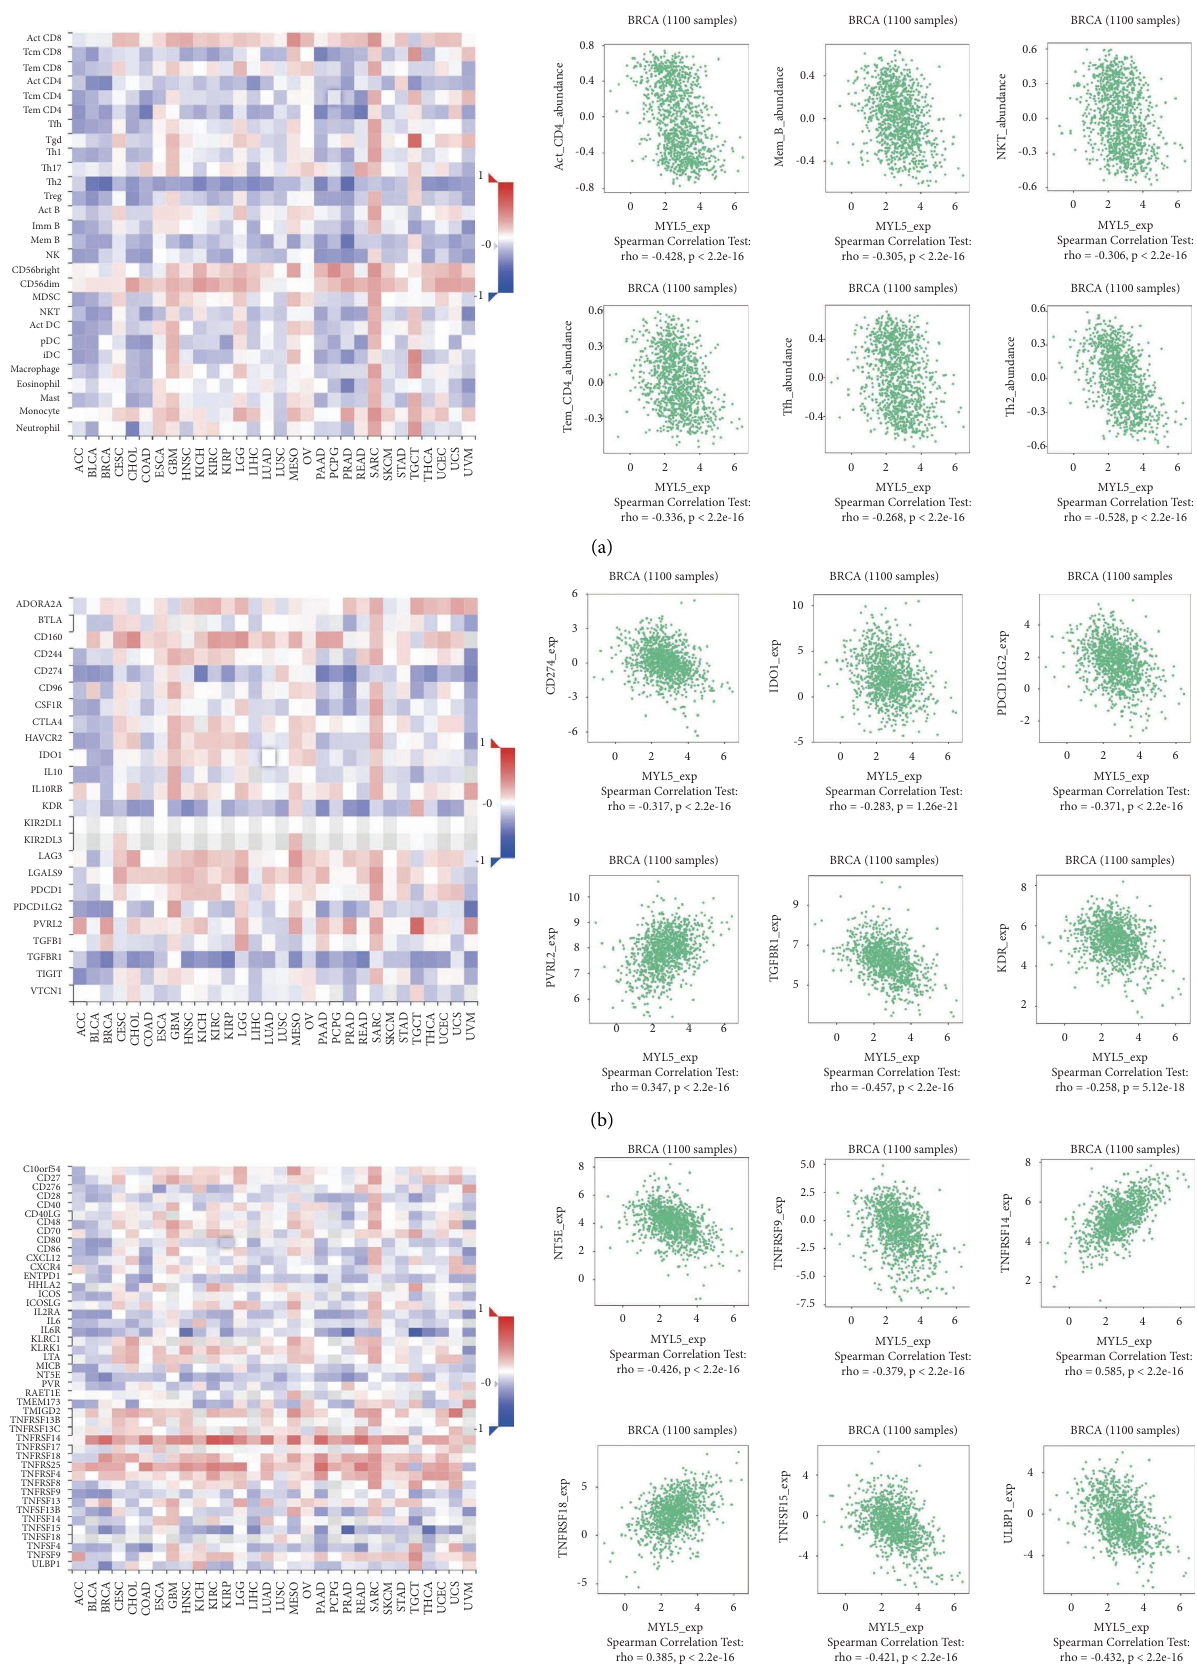
Spearman Correlation Test: rho = 0.385, p < 2.2e-16